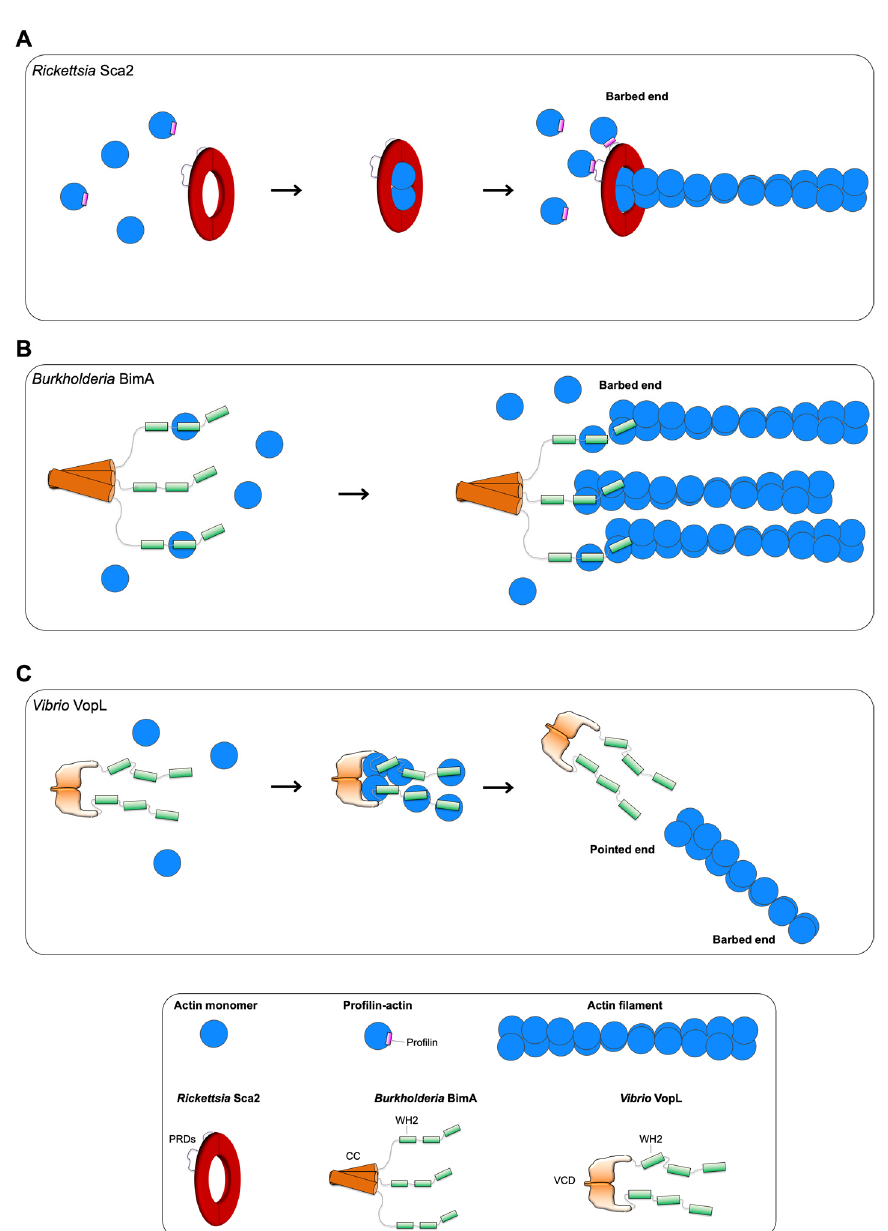
Figure 2. Current models of actin assembly by pathogen effectors that directly assemble actin. ( A ) Sca2 is proposed to adopt a formin-like mechanism, nucleating actin by encircling two actin subunits, and elongating the filament by tracking the barbed end and adding (proflin-)actin via its two PRDs. ( B ) BimA is proposed to adopt an Ena/VASP-like mechanism, nucleating and elongating actin filaments by a C-terminal trimerization coiled-coil and using putative WH2/GAB motifs to bind actin monomers. ( C ) VopL is a pointed end nucleator that assembles filaments by recruiting actin monomers with its WH2 motifs and using its VCD to organize the actin monomers in a filament-like arrangement.